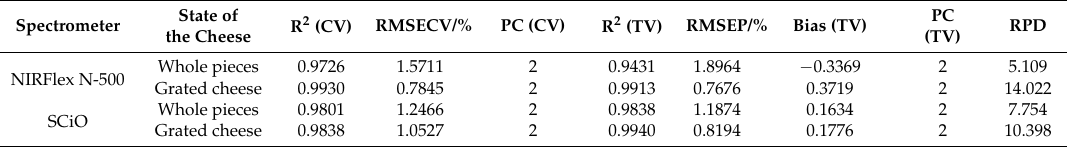
Table 2. Parameters of the established PLS-R models for fat content. CV denotes cross-validated models, whereas TV refers to test set-validated